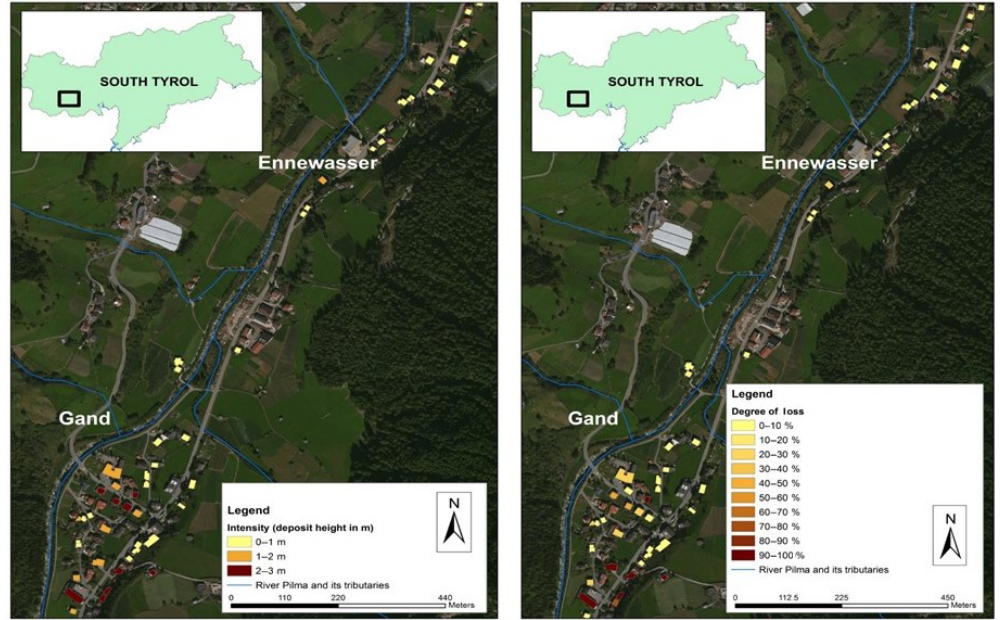
Figure 6. The spatial pattern of the assessed intensity of the 1987 event per building (left panel) and the corresponding degree of loss (right panel) in the villages Gand and